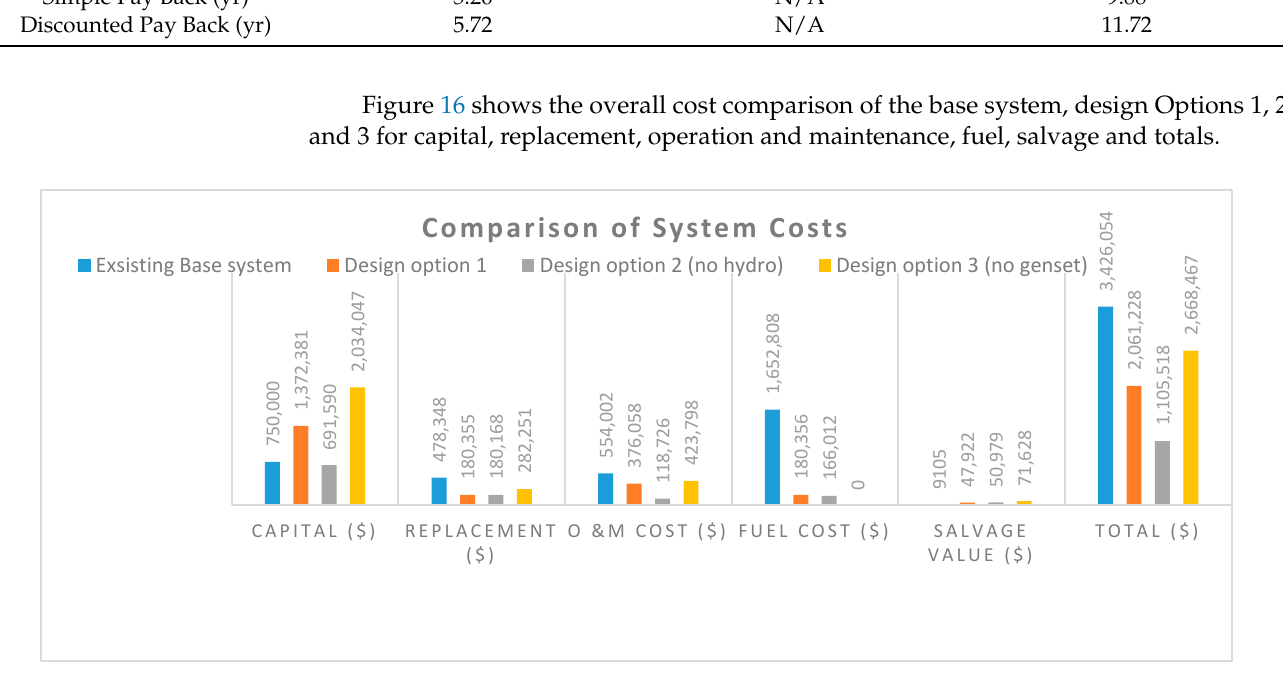
Figure 16. Comparison costs of base and proposed systems.